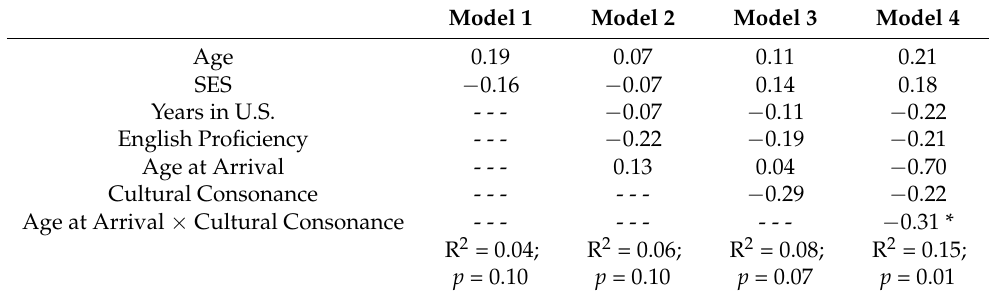
Table 5. Regression models of age at arrival and cultural consonance on depressive symptoms.